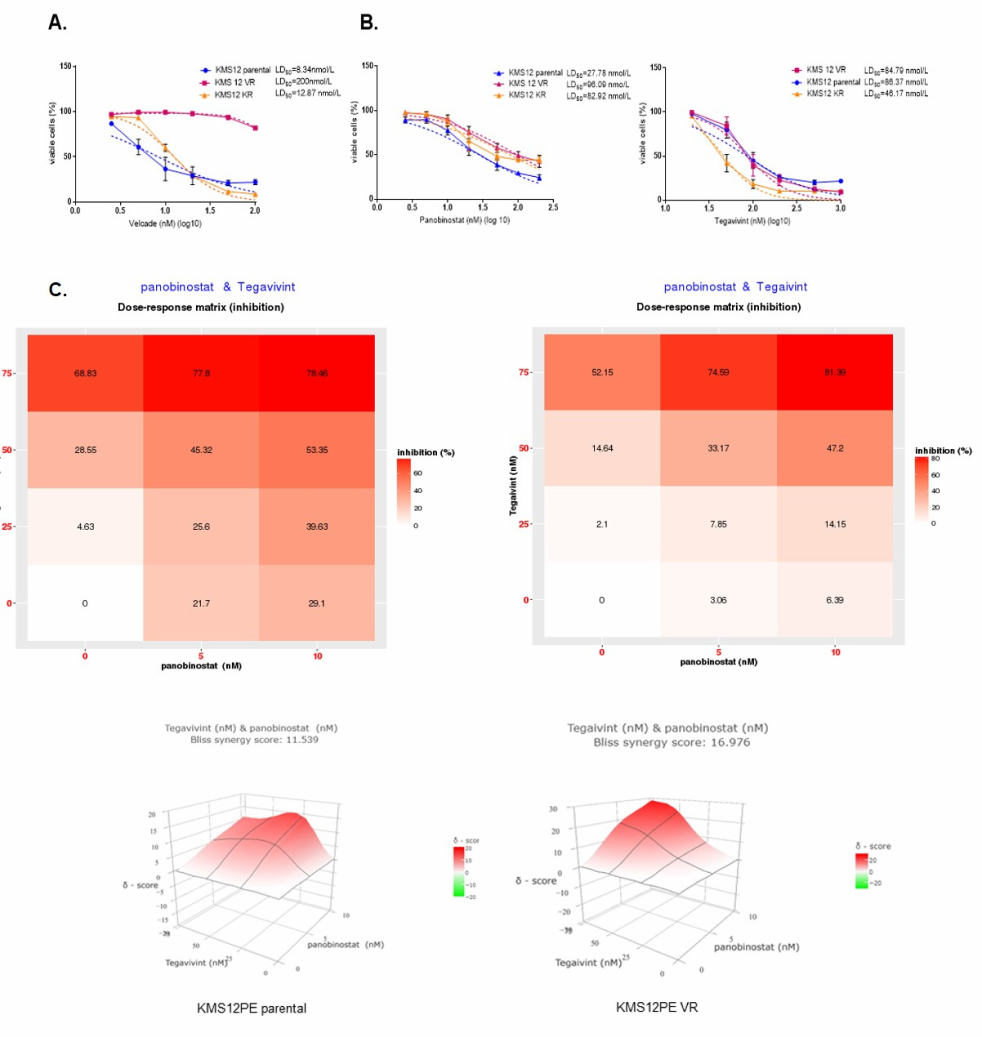
Figure 5. Tegavivint overcomes acquired panobinostat resistance in bortezomib resistant MM